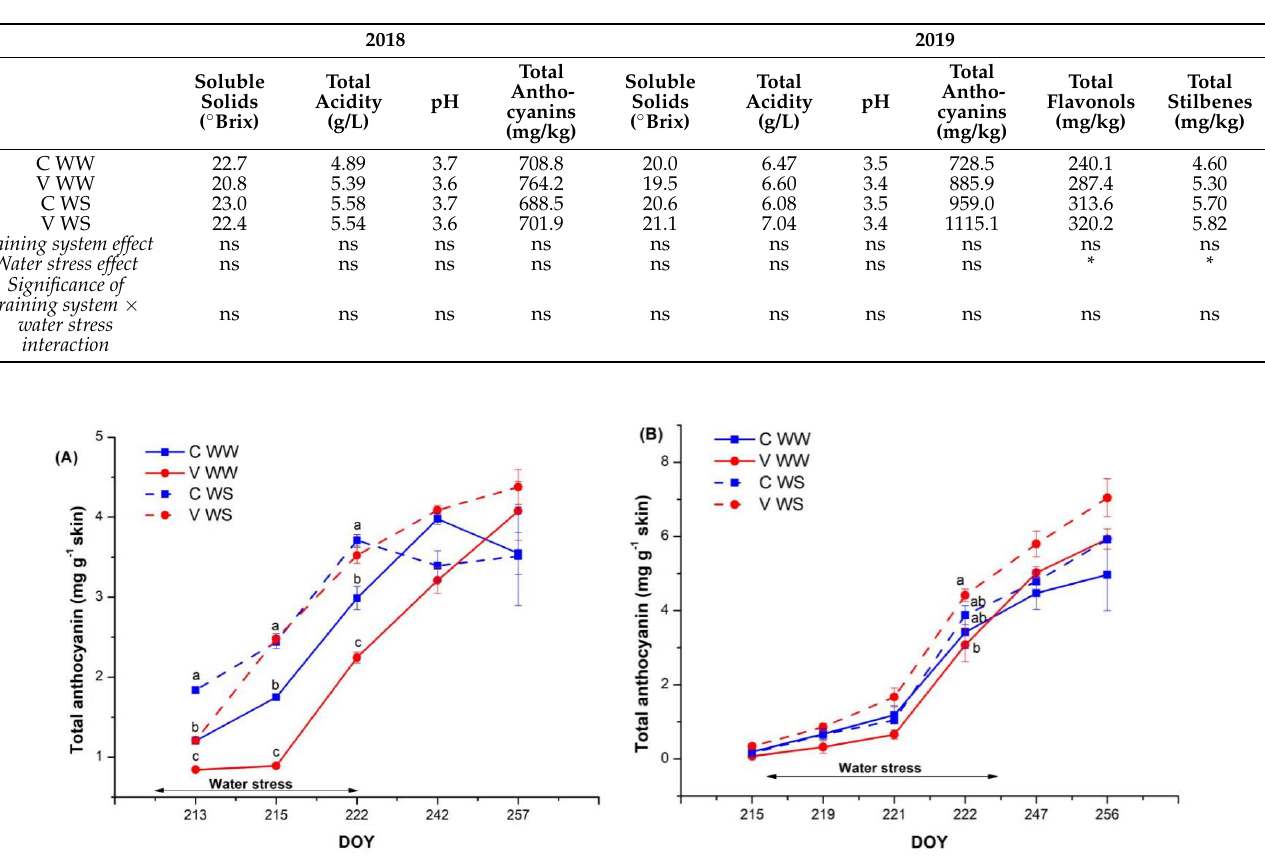
Table 7. Influence of treatments on the standard parameters of the must and on the polyphenolic content of Sangiovese vines in the 2018 and 2019 seasons. Values represent means of 4 replicates: C WW = well-watered vertical shoot-positioned canopy, V WW = well-watered V-shaped open canopy, C WS = vertical shoot positioned canopy with water restriction, V WS = V-shaped open canopy with water restriction. Significant differences are indicated: *, p < 0.05; ns, not significant. Mean values were separated within each column with different letters using the Tukey test.